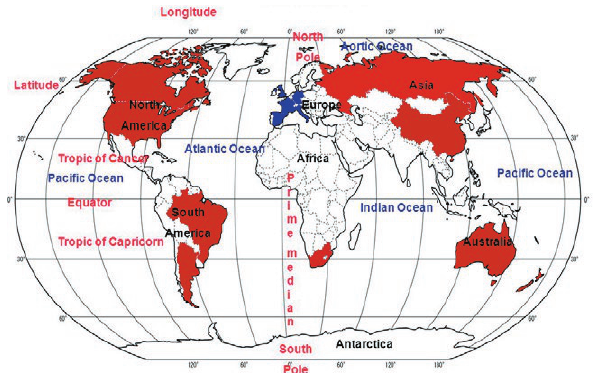
Figure 1. List of countries. Source: elaboration on Anderson and Nelgen (2015). Notes: Old World Producers in blue, New World Producers in red.